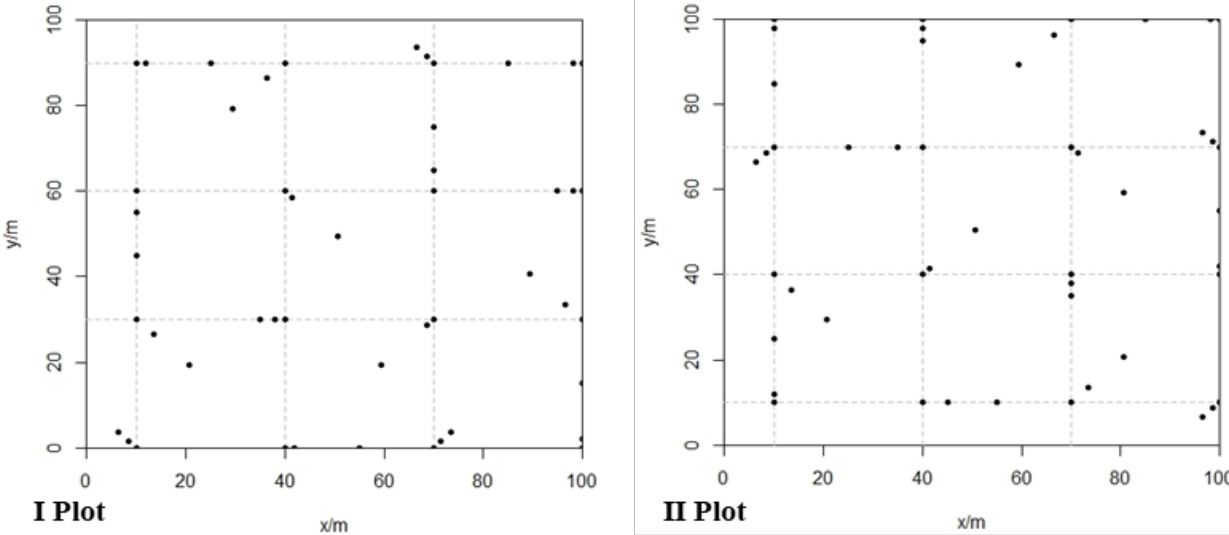
Figure 4. The spacial distribution of soil sample in the plots.